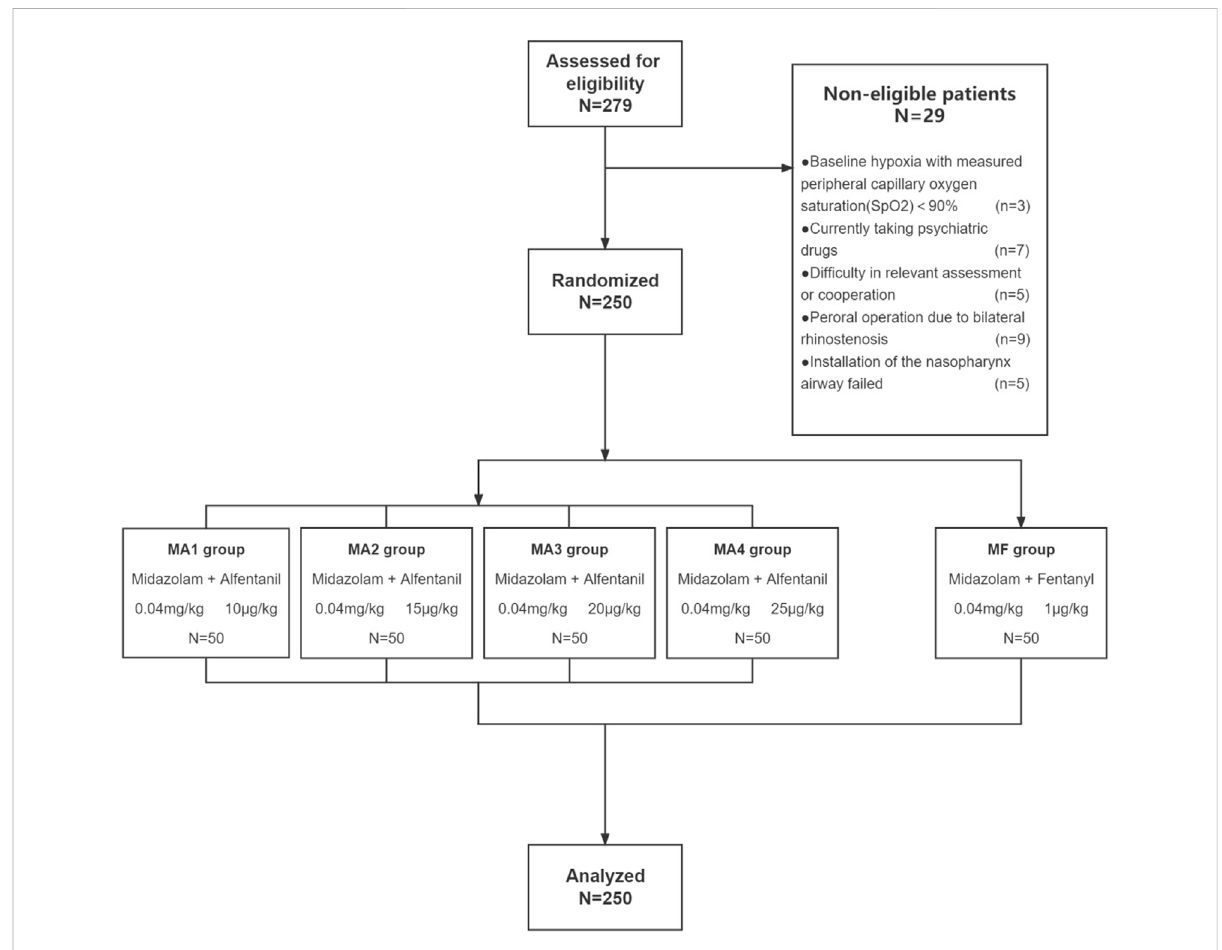
FIGURE 1 Flow diagram of the